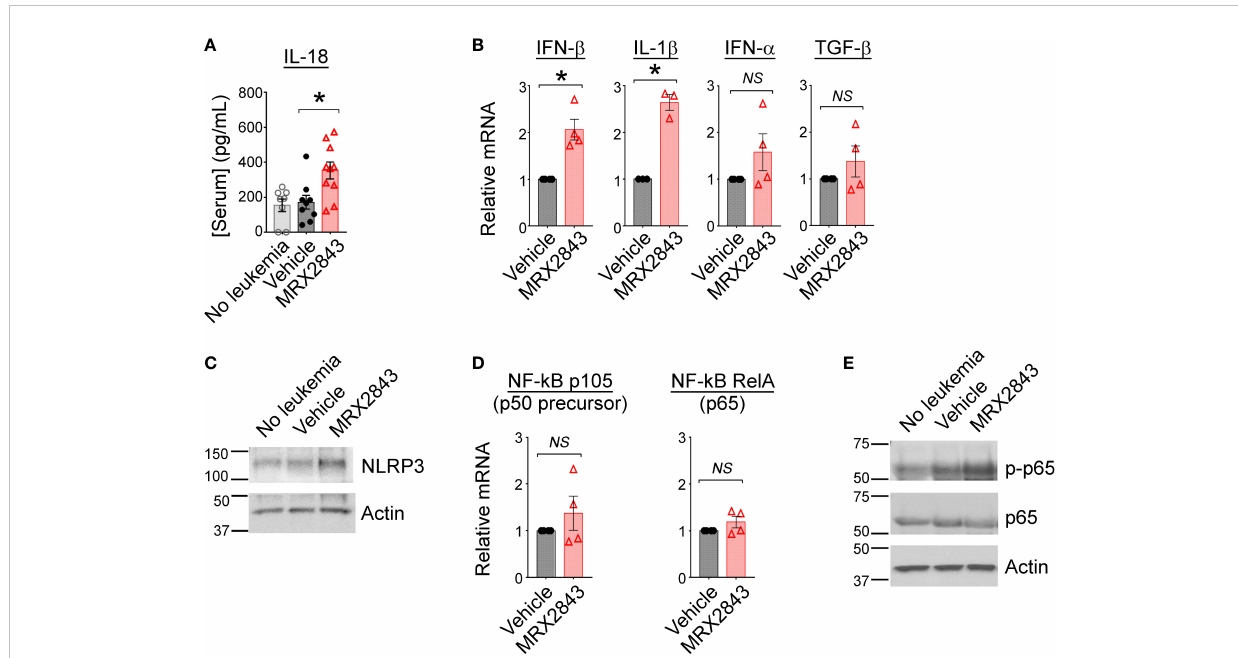
FIGURE 3 Inhibition of MerTK results in M1 cytokine production through activation of NF- k B. (A) Serum from mice described in Figure 1G was subjected to Luminex for interleukin-18 (IL-18); analyzed using 1-way ANOVA. (B) BMDM were co-cultured with MLL-ENL cells for 12 hours in the presence of MRX2843 or vehicle, then mRNA was harvested from adherent macrophages. Quantitative real time-PCR was performed, normalized to GAPDH expression, and then gene expression fold-change relative to vehicle-treated samples was calculated. Analyzed using Student ’ s t-test. (C) As described in Figure 2I, whole cell lysates from BMDM were analyzed by immunoblot. Representative immunoblot demonstrating NLRP3, a component of the in fl ammasome, is shown; Actin is used as a loading control. (D) RT-PCR was performed as described in (B) Gene expression fold- change of the p105 (precursor to p50) and RelA (p65) components of NF- k B relative to vehicle-treated samples was calculated. Analyzed using Student ’ s t-test. (E) Representative immunoblot demonstrating phosphorylated p65/RelA and total p65/RelA; Actin was used as a loading control. (*p<0.05, NS, not signi fi